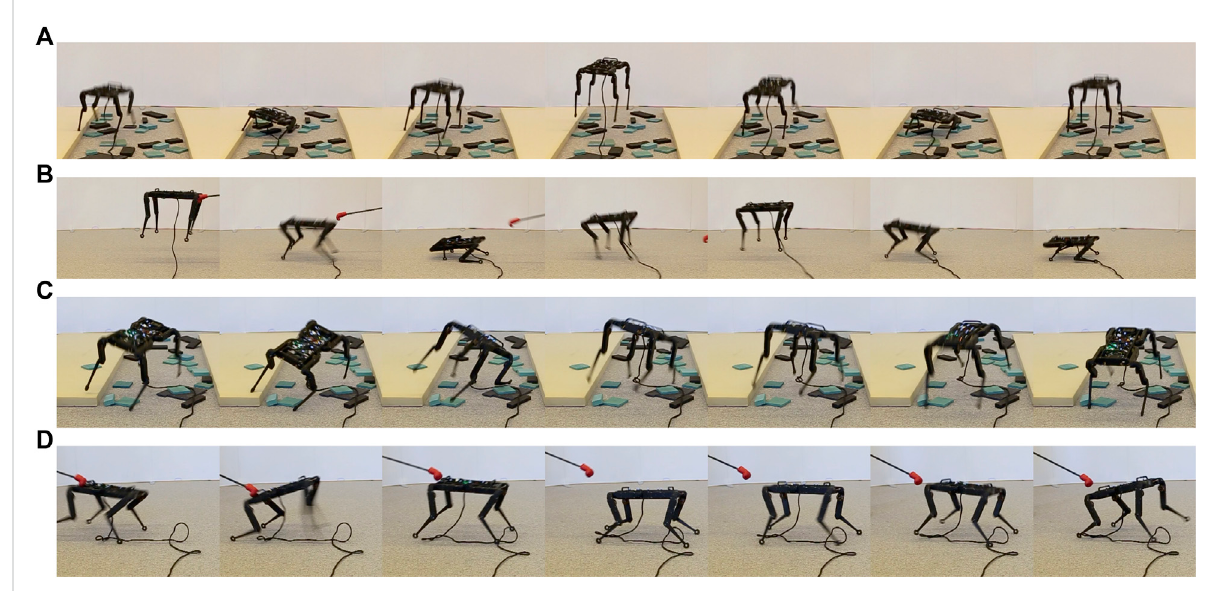
FIGURE 2 Examples of the robustness tests carried out on the quadruped robot Solo8 (A) Hopping on a surface comprised of a soft mattress and small blocks (B) Hopping with push recovery (C) Bounding on a surface comprised of a soft mattress and small blocks (D) Bounding with push recovery.